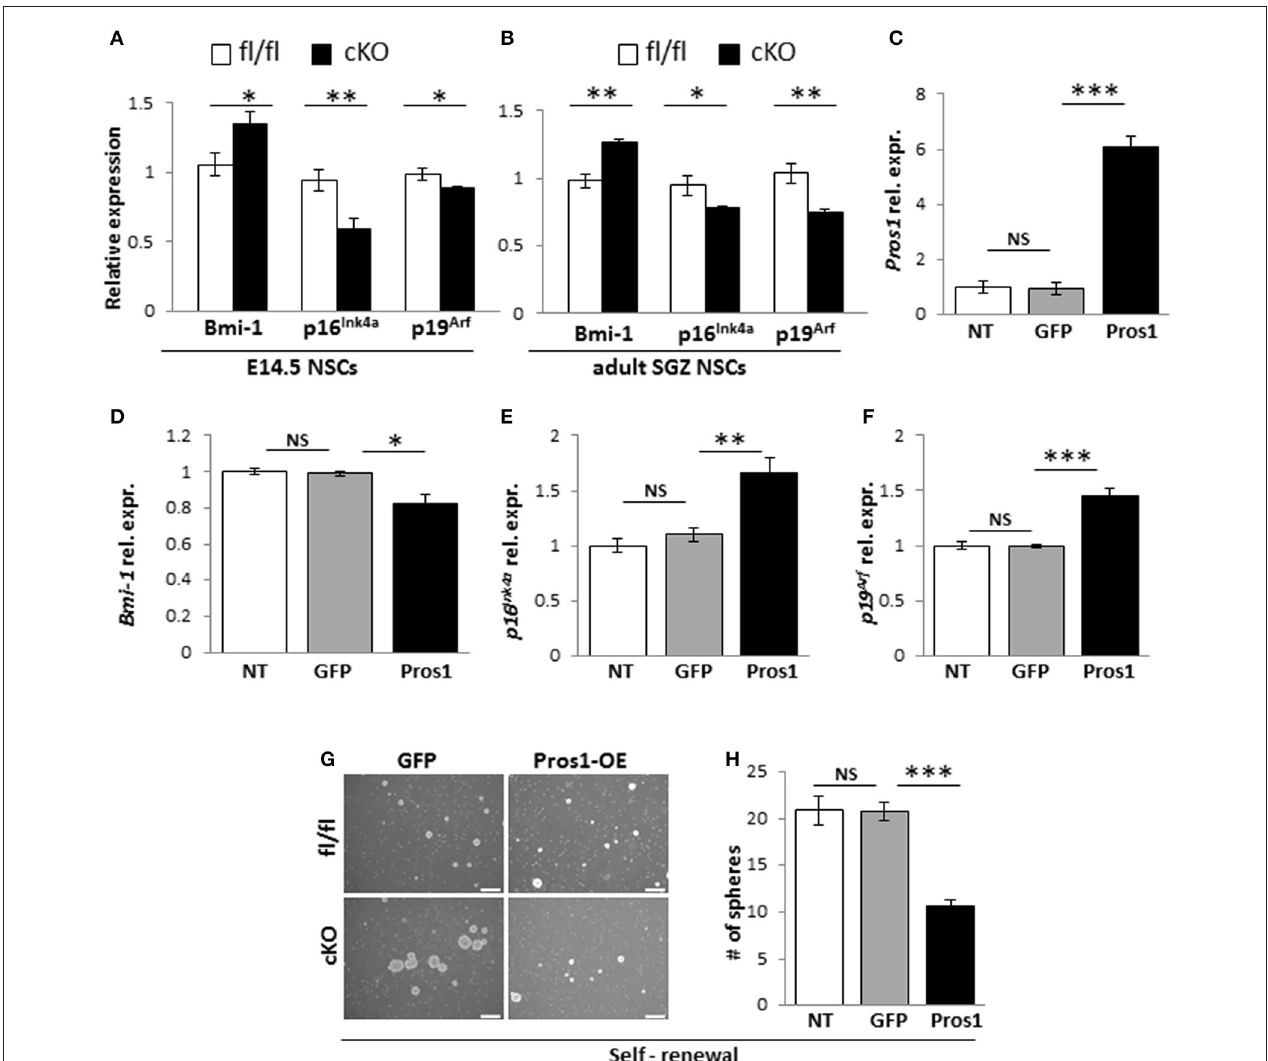
FIGURE 4 | Pros1 suppresses NSC self-renewal through Bmi-1 inhibition. (A,B) RT-qPCR relative expression levels of Bmi-1, and the Bmi-1 downstream genes p16 Ink4a and p19 Arf in neurospheres derived from E14.5 (A) and adult SGZ (B) NSPCs from control (white bars) and cKO (black bars) cells. Mean values ± SEM were derived from 4 individual experiments. A minimum of three and up to five embryos per genotype or 3–4 adult mice were pooled in each experiment. (C–F) Rescuing Pros1 expression in cKO NSPCs restores Bmi-1 signaling. (C) Pros1 expression was determined by qRT-PCR from neurospheres derived from Pros1 -cKO NSPCs from non-treated control (NT, white bar), GFP-electroporated control (gray bar), and Pros1 -electroporated (black bar) NSPCs. *** P < 0.001; NS, no statistical significance. All cells were allowed to grow for 3 days following electroporation. Graphs represent mean values ± from four individual experiments, with at least two embryos from each genotype pooled in each experiment. (D–F) Rescuing Pros1 expression downregulates Bmi-1 levels ( D ; P = 0.03), along with upregulation of p16 Ink4a ( E ; P = 0.013) and p19 Arf ( F ; P = 0.001) in cKO NSPCs treated with a Pros1-expressing vector (black bars). Non-treated NSCs (NT, white bar), or cells electroporated with a GFP control vector (gray bar) were not affected. NS, no statistical significance. Graphs represent mean values ± from four individual experiments. At least two embryos from each genotype pooled in each experiment. (G,H) Phenotypic rescue following PROS1 rescue in cKO NSPCs. Phase contrast (G,H) quantification of self-renewal rates performed on non-treated (NT, white bar), control-electroporated (GFP, gray bar) or Pros1 -electroporated (Pros1, black bar) cells. *** P < 0.0001; NS, no statistical significance. At least 60 neurospheres per genotype were scored for statistical evaluation. Graphs represent mean values ± from four individual experiments. *** P < 0.001; ** P < 0.01; * P <